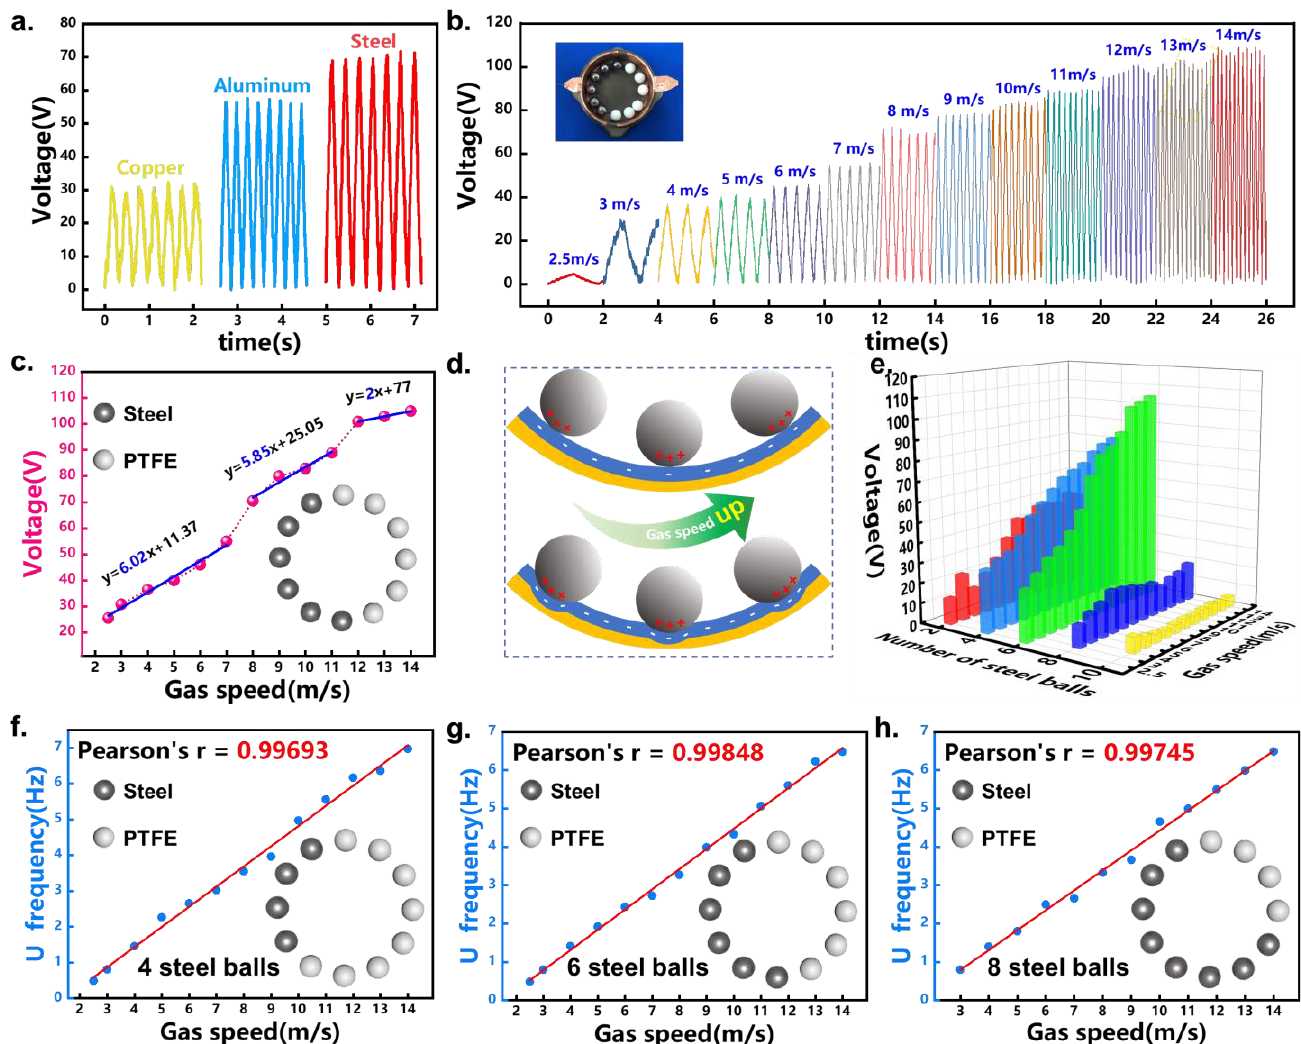
Figure 3. Output performance of the B-TENG. ( a ) output performance of the B-TENG with copper, aluminum and steel balls under gas speed of 8 m/s; ( b ) output voltage of the B-TENG under different gas speed. ( c ) the rising tendency of the output voltage under different gas speed; ( d ) contact status between steel ball and PTFE film ( e ) output voltage trend of the B-TENG with different number of steel balls under different gas flow; the FFT result of the output voltage signal of the B-TENG with ( f ) 4, ( g ) 6, and ( h ) 8 steel balls under different gas speeds.